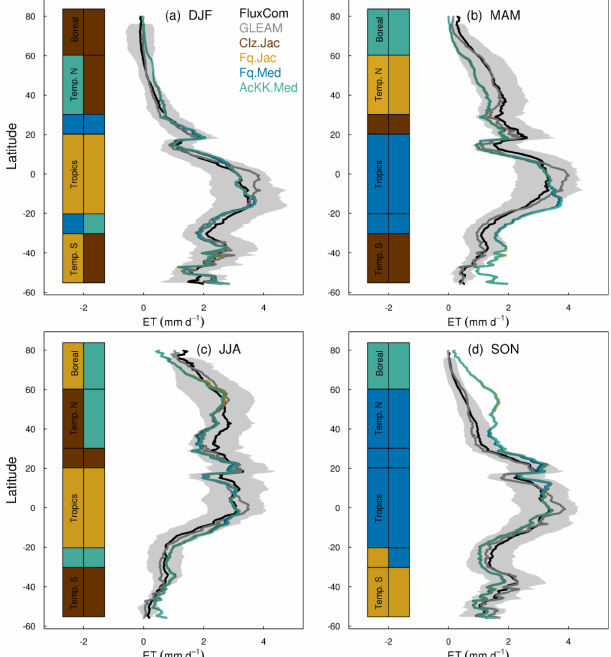
Figure 4. Mean (2002 to 2012) GPP (gCm 2 d − 1 ) by latitude band and season for each JULES model configuration compared to the FluxCom and MOD17 global GPP products. The bars along the side indicate which model configuration gives the lowest RMSE and therefore better comparison to FluxCom (righthand bar) and MOD17 (left-hand bar) derived GPP for each region. RMSE val- ues are shown in Tables S4 (FluxCom) and S5 (MOD17). The grey shaded area shows the uncertainty in the FluxCom GPP product, provided as the median absolute deviation of ensemble members, this is scaled to a robust estimate of the standard deviation of a normal distribution by multiplying by 1.4826 according to Jung et al. (2019).